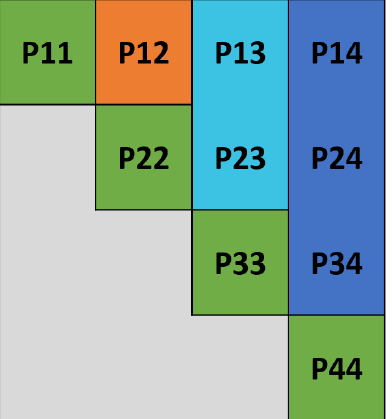
Figure 5. Block-streaming method with 4 blocks ( B / B max =